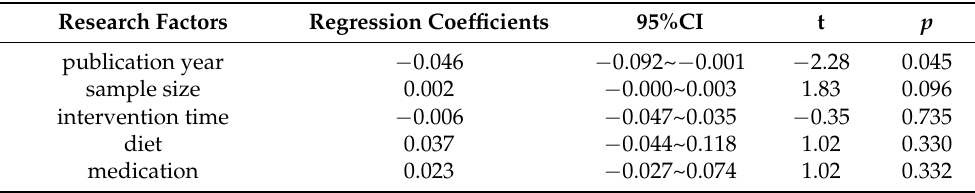
Table 3. Meta regression analysis of heterogeneous factors of TC.